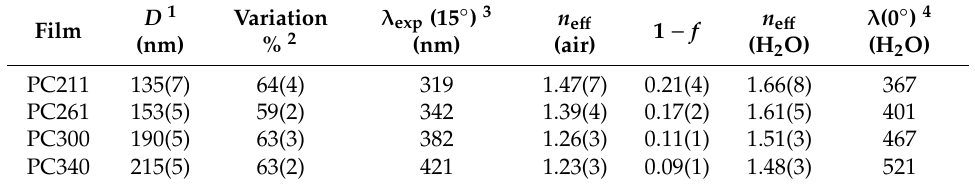
Figure 1. Top-view SEM images of ( a ) PC211, ( b ) PC261, ( c ) PC300, ( d ) PC340, ( e ) GQD-PC211 inverse opals, and ( f ) cross-section image of PC340. Top-view ( g ) and cross-section ( h ) images of P25 films. Table 1. Structural and optical parameters of the TiO 2 photonic crystal (PC)